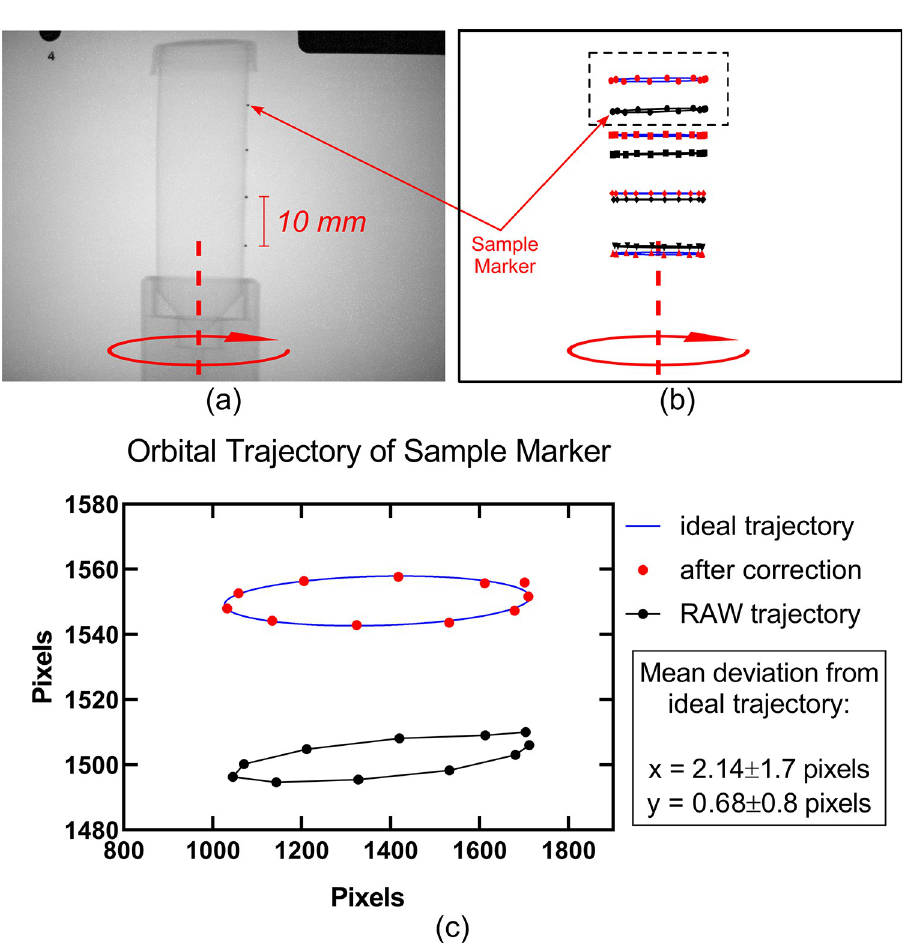
Fig 8. Results of geometric calibration evaluation using a cylindrical phantom with four radiopaque marker beads. (a) x-ray projection radiograph of the phantom; (b) uncorrected and corrected elliptical trajectories prescribed by the phantom’s markers over the course of one full rotation of the rotary stage. (c) close-up of uncorrected and corrected elliptical trajectories of the top-most marker bead. The corrected position of the markers aligns with the ideal trajectory calculated using a sinusoidal best